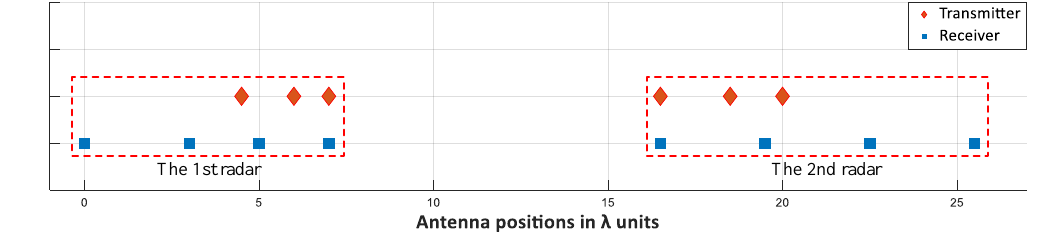
Figure 13. The simplified optimized MAM-MIMO sparse array for CARs. Table 6. Transmitter and receiver positions of the example for experiments. x T, I and y R, I in λ